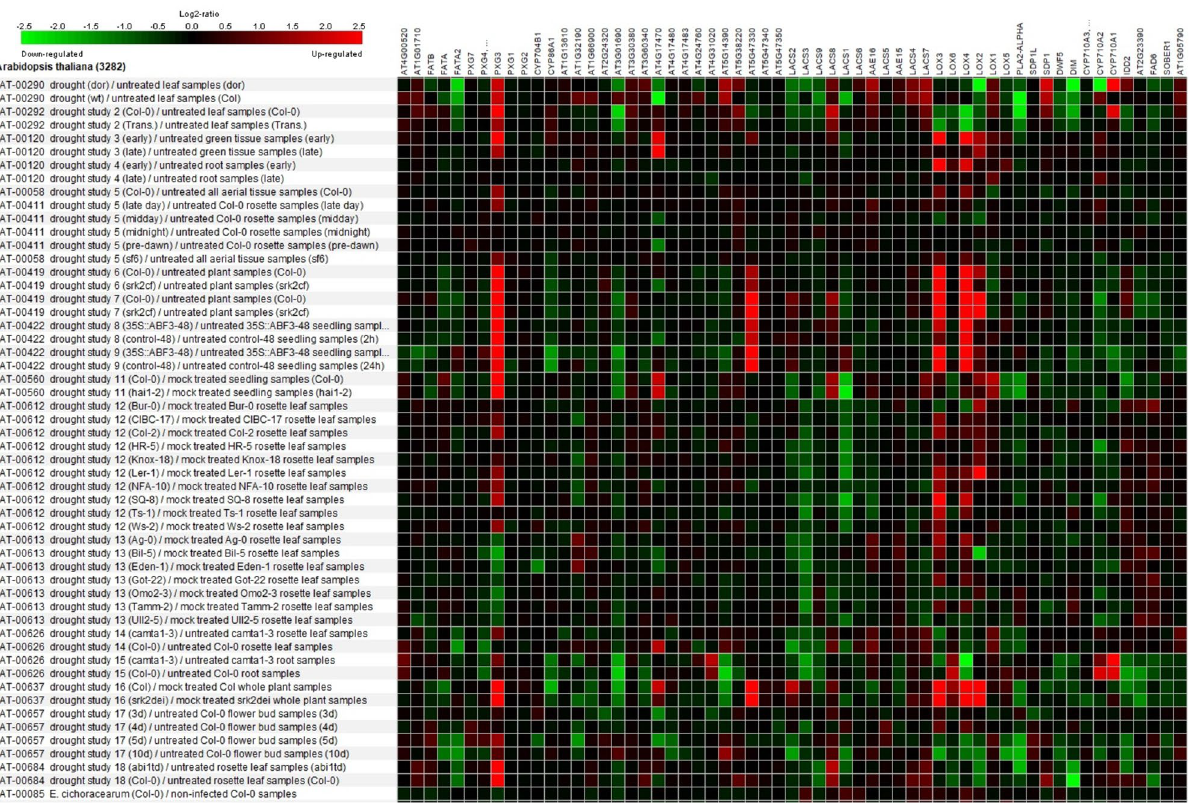
Figure 3. Expression analysis of milk thistle lipids synthesizing genes by Genevestigator software and Biclustering tool. Y-axis contains Arabidopsis gene expression dataset and the X-axis contains our input genes. Red color indicates up-regulated and green color indicates down-regulated